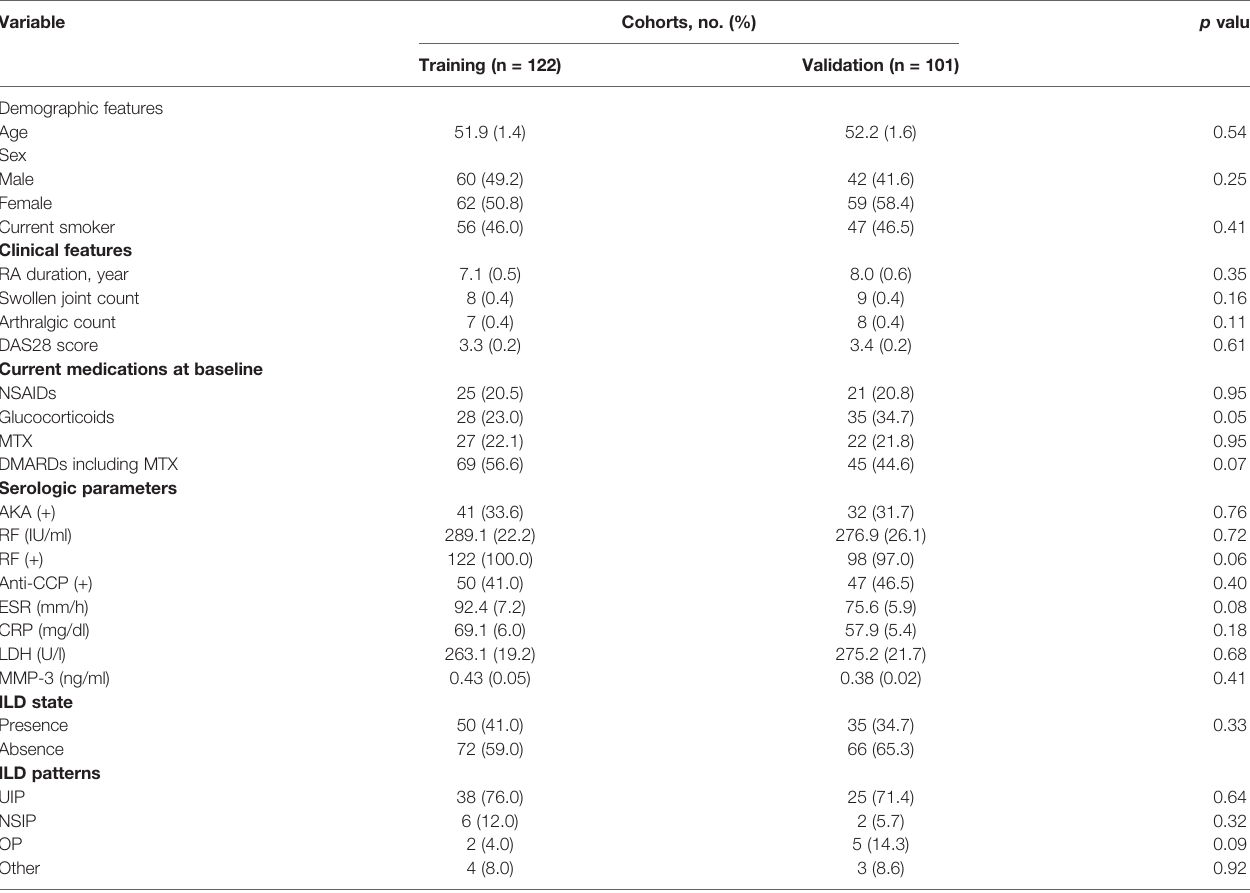
TABLE 1 | Baseline demographic and clinical features of training and validation